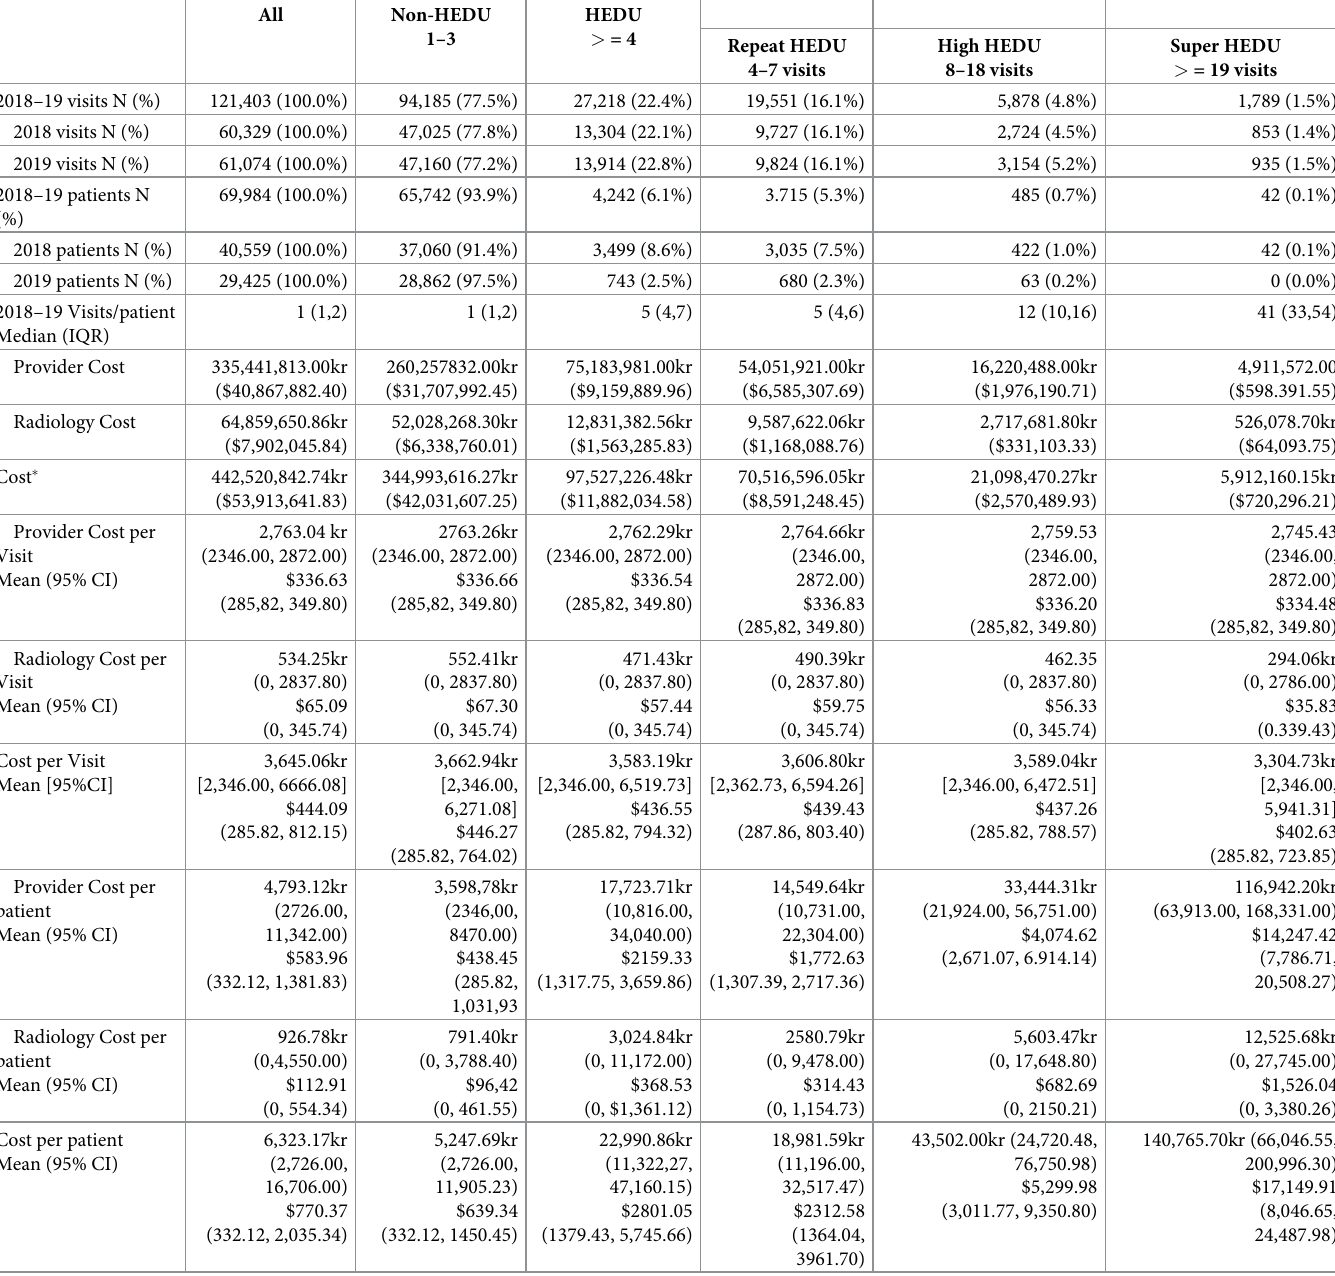
Table 2. Comparison of visit, patient and costs by HEDU